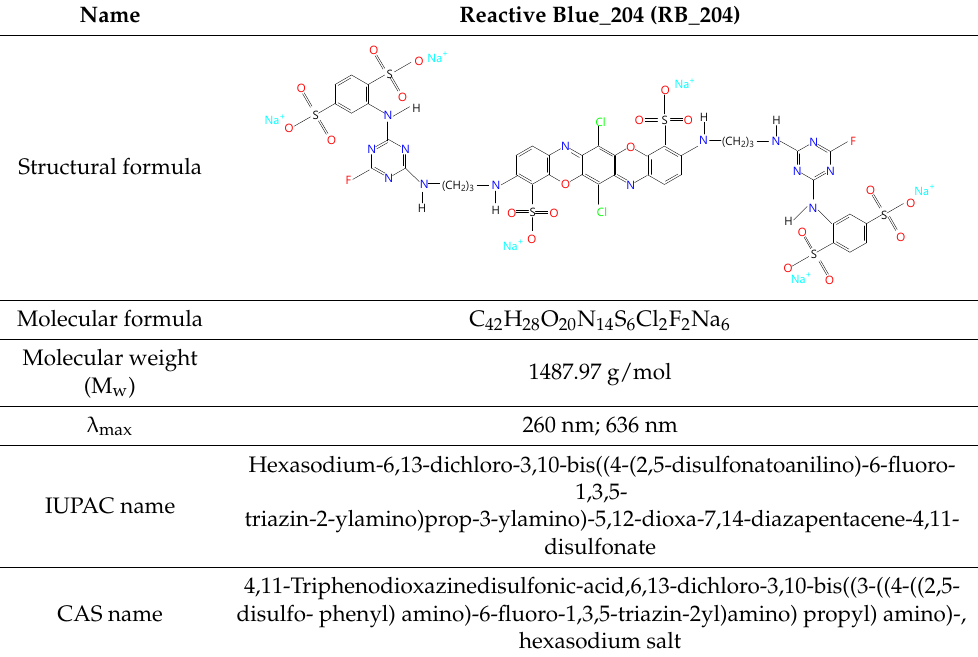
Table 1. The characteristic data of RB_204.